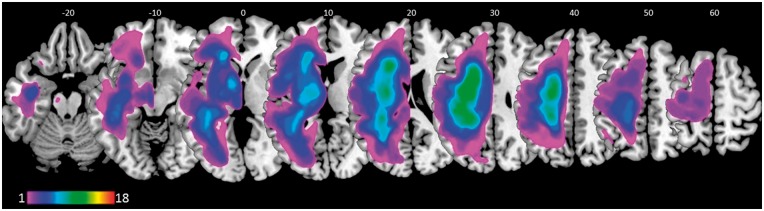

Lesions overlap in our sample of patients. Colour range indicates the amount of overlap expressed as number of patients (colour bar). Numbers on the top represent z MNI coordinates of brain sections, displayed in neurological convention (i.e. L is L, R is R).